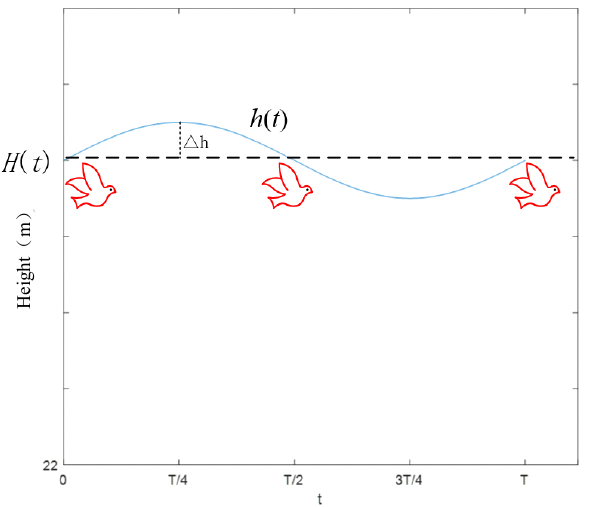
Figure 11. Variation curve of centroid height and periodic equivalent height during cruise flight.